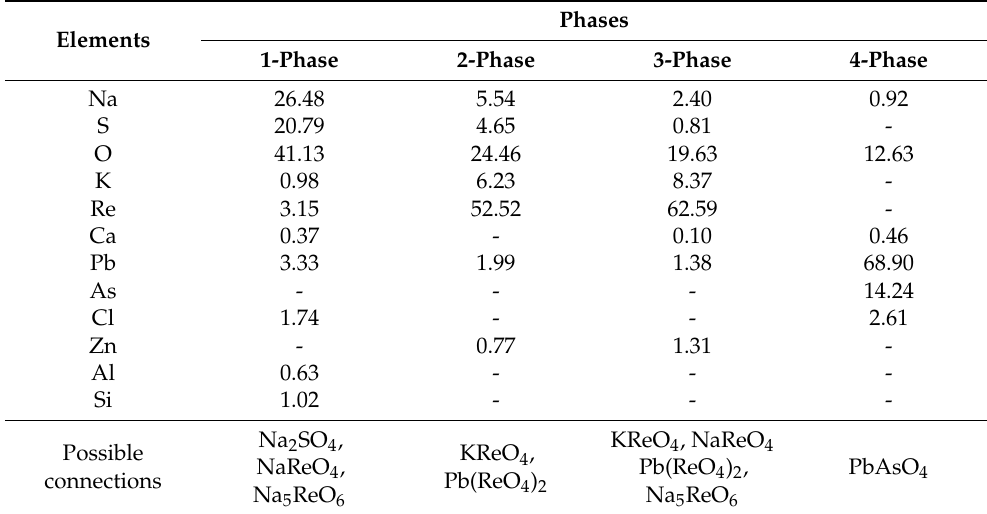
Table 3. Results of microprobe elemental analysis of various phases of sodium sulfate slag, %.